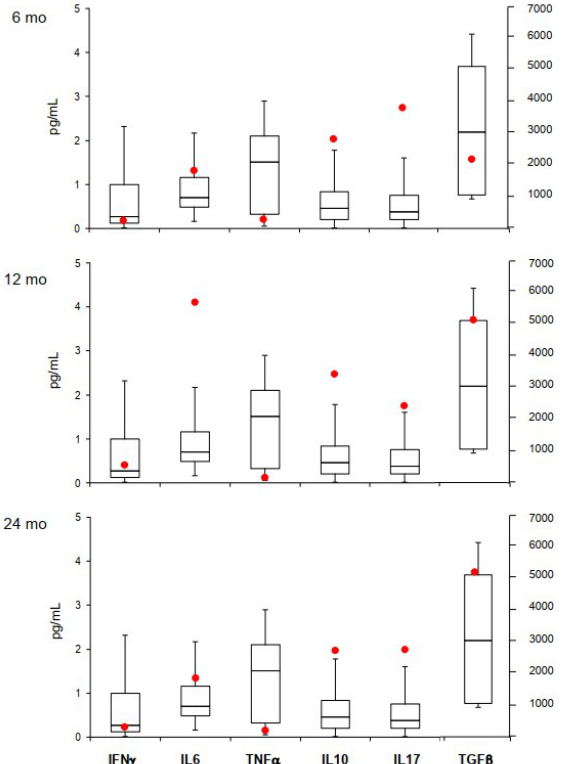
Figure 3. Cytokine levels during eltrombopag treatment. Red dots represent patient’s values; boxplots represent the median, quartiles, and ranges for cytokine levels in 40 age- and sex-matched healthy controls. IFN-γ, interferon gamma; IL, interleukin 6, 10, 17; TGF-β transforming growth factor beta; TNFα, tumor necrosis factor alpha; 6, 12 and 24 months (mo) of eltrombopag treatment.